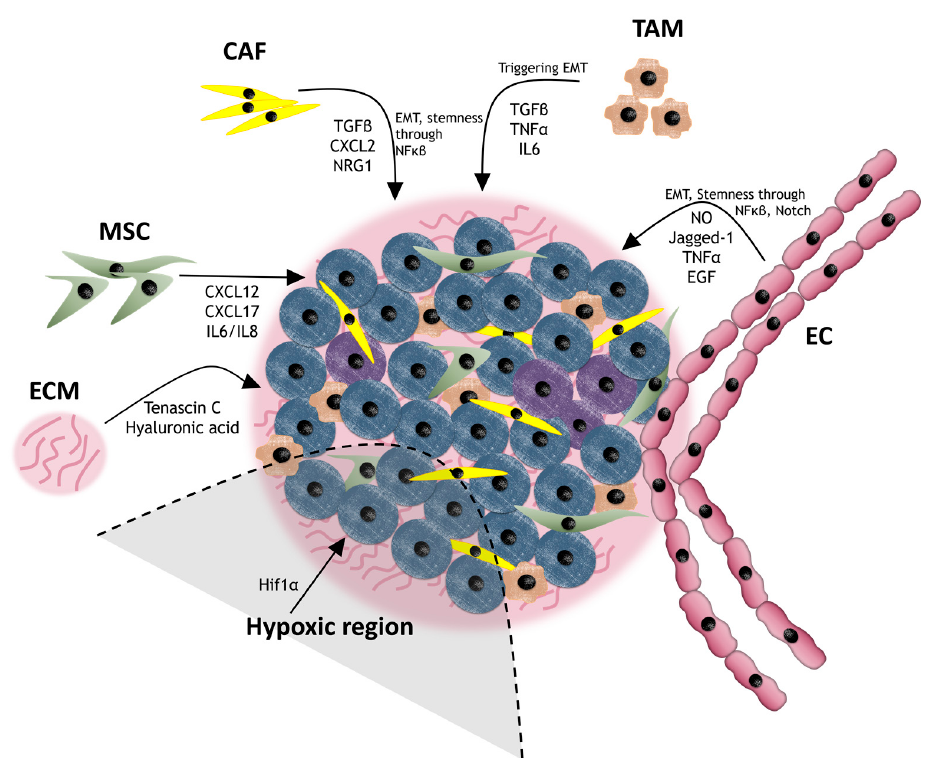
Figure 2. CSCs (represented as purple cells) within the cancer niche, surrounded by CAFs, TAMs, ECs, MSCs and ECM. The CSCs are situated in a hypoxic region and are receiving stimuli from neighboring cells that increase drug resistance. Table 1. Molecules secreted by cancer niche components that promote drug resistance in CSCs.